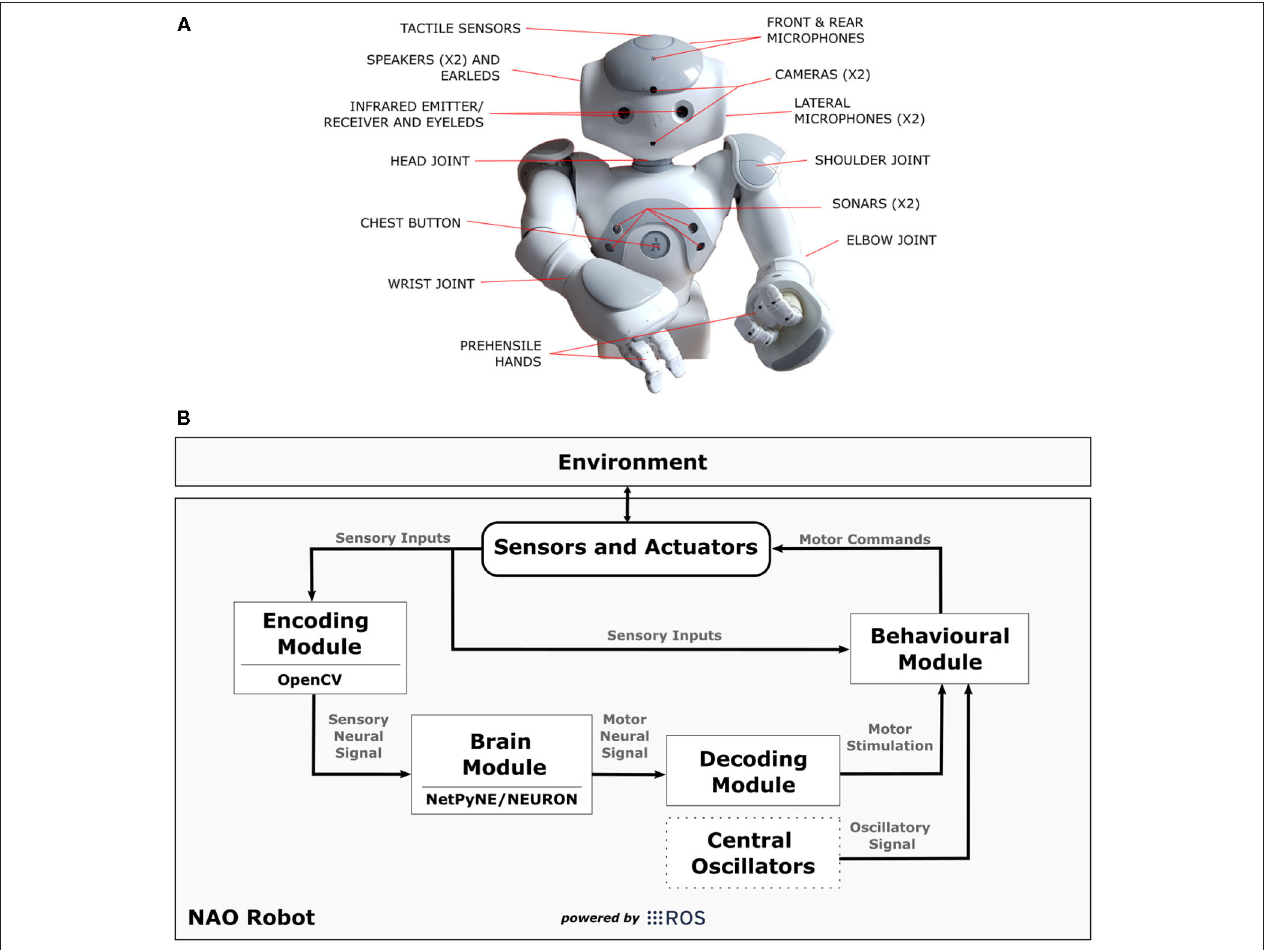
FIGURE 6 | In (A) , technical illustration of NAO T14 robot indicating the position of sensors and actuators. (B) Shows a diagram illustrating the connections between the modules [Encoding Module (EM), Brain Module (BM), Decoding Module (DM), Behavioural Module (BeM)] and NAO robot in the SML. The modules represent different applications that complement each other during the task, and the arrows indicate the data flow. The Central Oscillators generate the oscillatory signals mimicking the inherent oscillatory patterns that are related to motor control and may be linked to parkinsonian tremor. ROS was mainly used as a platform to support communication between those elements and to interact with the robot by reading its sensors and sending commands to its